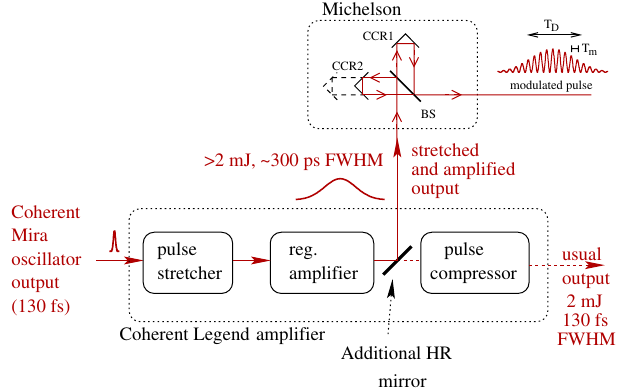
FIG. 2. (Color) Detail of the pulse shaping system. A regenera- tive chirped pulse amplifier (Coherent Legend) is slightly modi- fied. A high-reflectivity mirror is placed between the amplifier and the compressor, to extract the high-energy stretched pulses. These latter are sent to a Michelson interferometer, and the resulting modulated pulses are then focused on the electron beam, as in usual slicing experiments . CCR1 and CCR2 are high precision corner cube hollow retroreflectors from PLX Inc. (OW-25-0563), i.e., with 63 mm total aperture, < 0 : 5 arc sec deviation, and (cid:2)= 4 wavefront distortion (@ 633